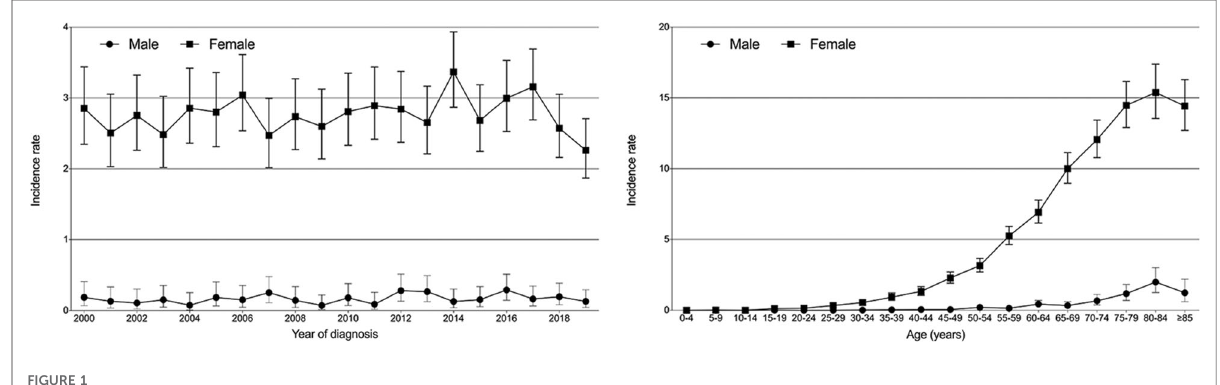
FIGURE 1 Incidence trends over the diagnosis year and age in male and female patients with primary breast